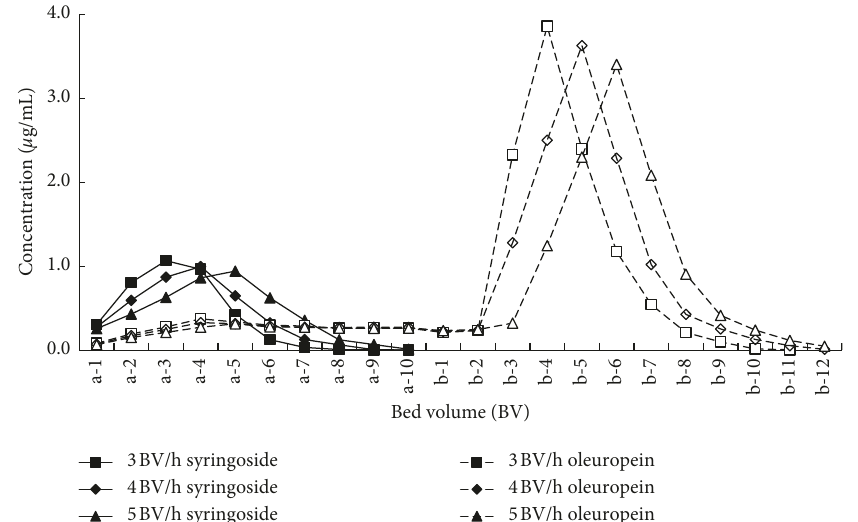
Figure 7: Desorption curves of syringoside and oleuropein with different flow rates; a series in the X -axis represent 20% ethanol elution; b series in X -axis represent 40% ethanol elution.